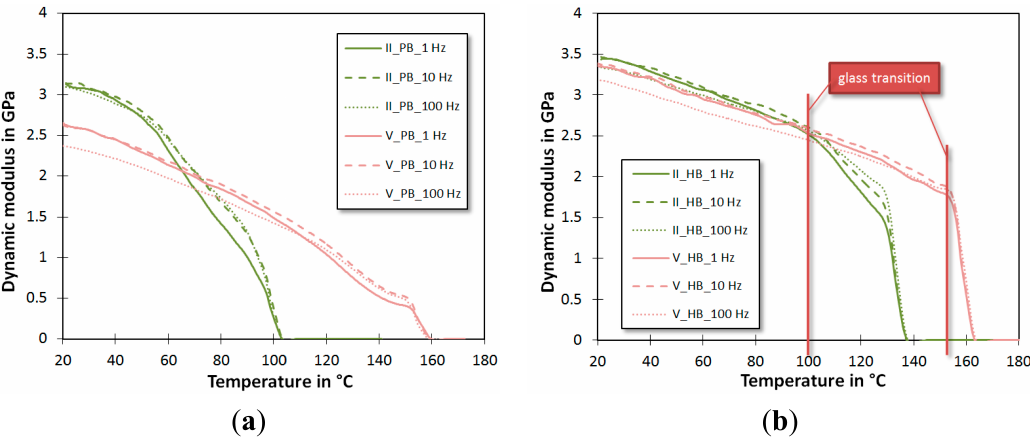
Figure 5. Dynamic modulus of SU-8 samples II and V (see Table 1) versus temperature (heating rate 1 K/min, 1 N sinusoidal load): ( a ) After postbake and ( b ) after